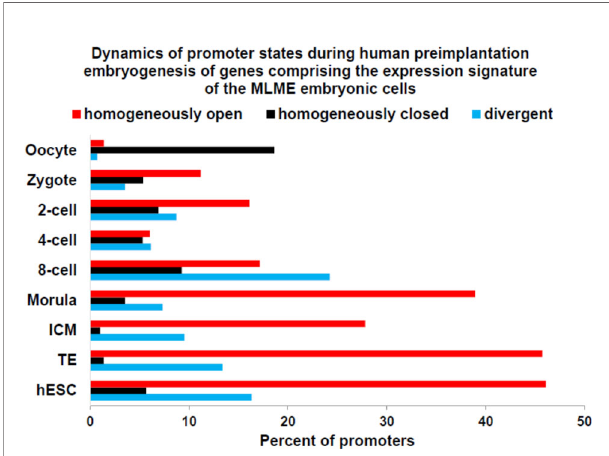
FIGURE 2 | Dynamics of promoter state ’ s changes of genes comprising GES of human embryonic MLME cells during human preimplantation embryogenesis. Graphs re fl ect the gradual transition from predominantly homogenously closed (silent) promoter state in the oocyte to predominantly homogenously open (active) promoter state at the morula stage. Homogenously open promoter states of genes comprising the MLME GES (18) are maintained in human embryonic cells of the ICM, TE, and hESC. Divergent promoter state de fi nition refers to a transitional state of partially closed and partially open promoters. Promoter states of human genes at different stages of preimplantation embryogenesis were reported elsewhere